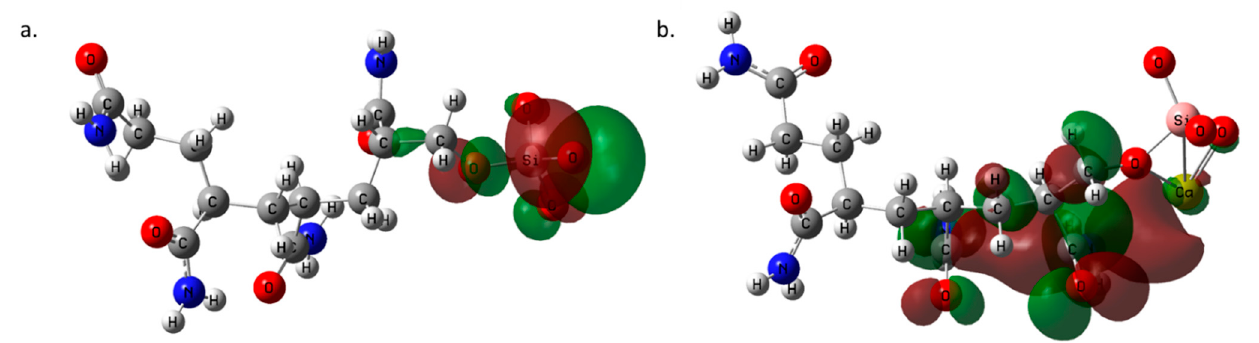
Figure 6. The Lowest Unoccupied Molecular Orbital (LUMO) maps for ( a ) PAM ‐ Silica and ( b ) Ca ‐ PAM_Silica.